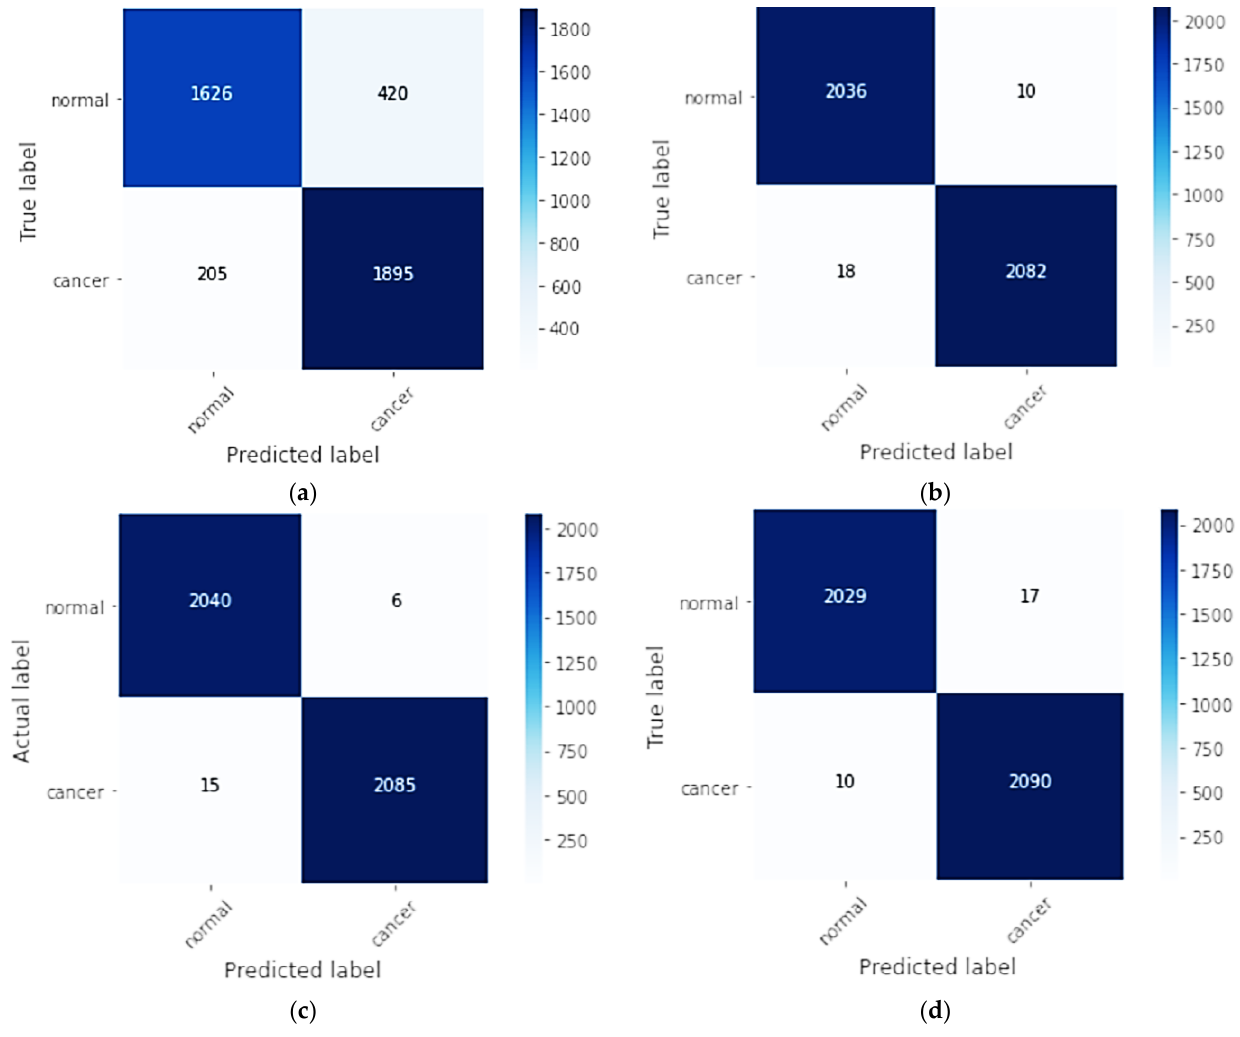
Figure 3. Aggregate confusion matrix of all folds for each model as: ( a ) CNN model; ( b ) CNN-SL model; ( c ) CNN-HD model; ( d ) CNN-SF model.